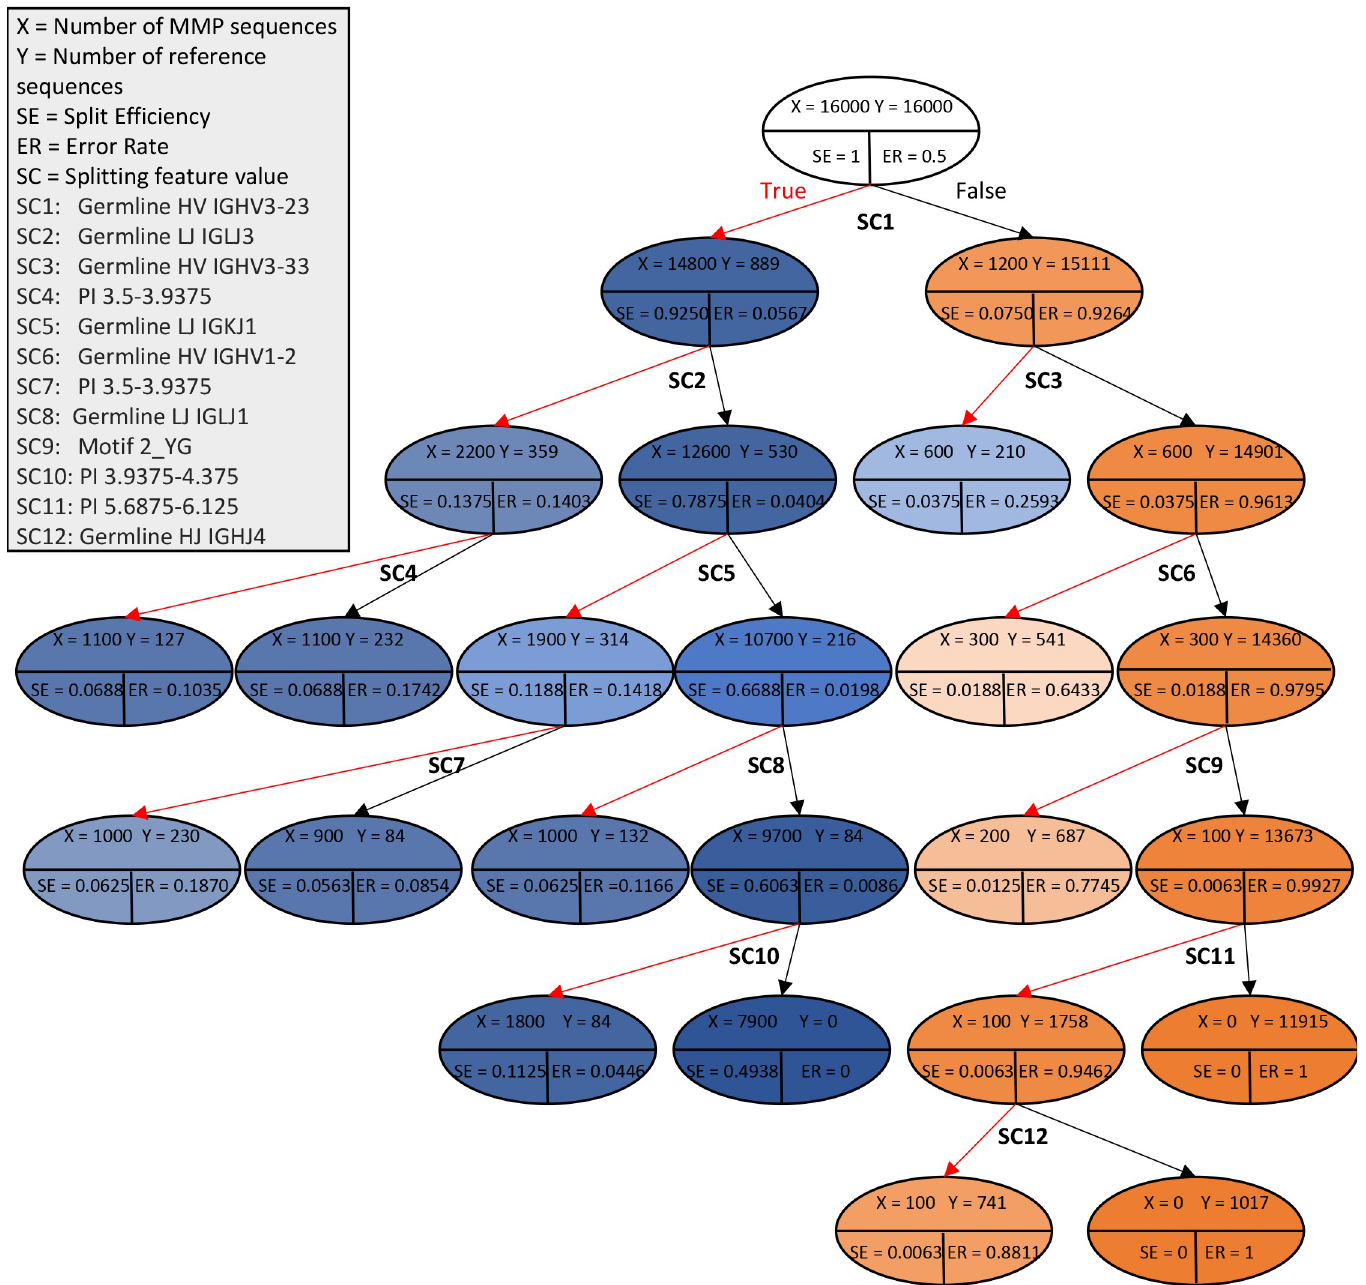
Fig 4. Design recommendation tree for the MMP-targeting antibody test case. Each node lists the number of MMP sequences (X), and the number of reference sequences (Y), along with the splitting efficiency and error rate. The label under each node, when present, reflects the splitting feature value and is expanded in the legend. Blue nodes are dominated with targeting antibody sequences, while orange nodes are dominated with reference antibody